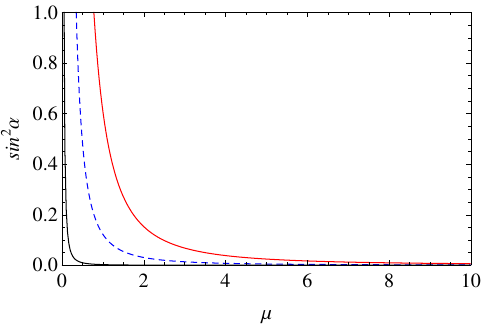
Figure 3. The angle as the function of impact parameter with the parameters γ = 1 , P = 0 . 0003 , q = 1 . 9 , M = 2. The observer’s position varies from 1 to 1000 from the red line to the black